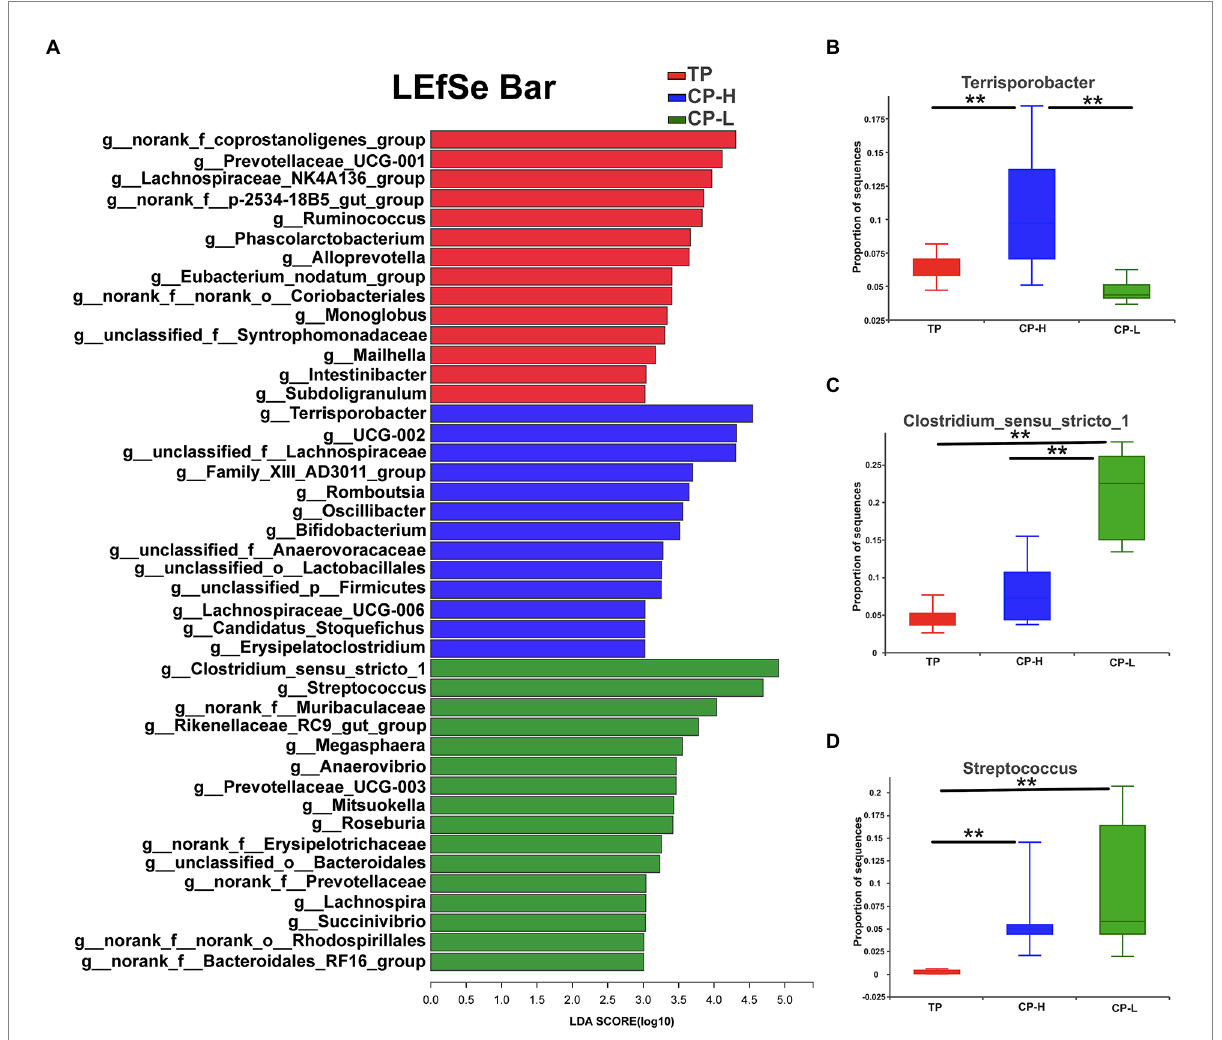
FIGURE 5 The differentially abundant taxa among the three groups by LEfSe analysis, and analysis of variance about some specific bacteria genera. TP: positive control group, CP-H: treatment group, CP-L: negative control group. (A) LEfSe analysis of microbiota in colonic chyme. (B) Analysis of variance about Terrisporobacter . (C) Analysis of variance about Clostridium_sensu_stricto_1 . (D) Analysis of variance about Streptococcusare . Data are expressed as mean ± SEM ( n = 6). ** indicating a highly significant difference ( p <